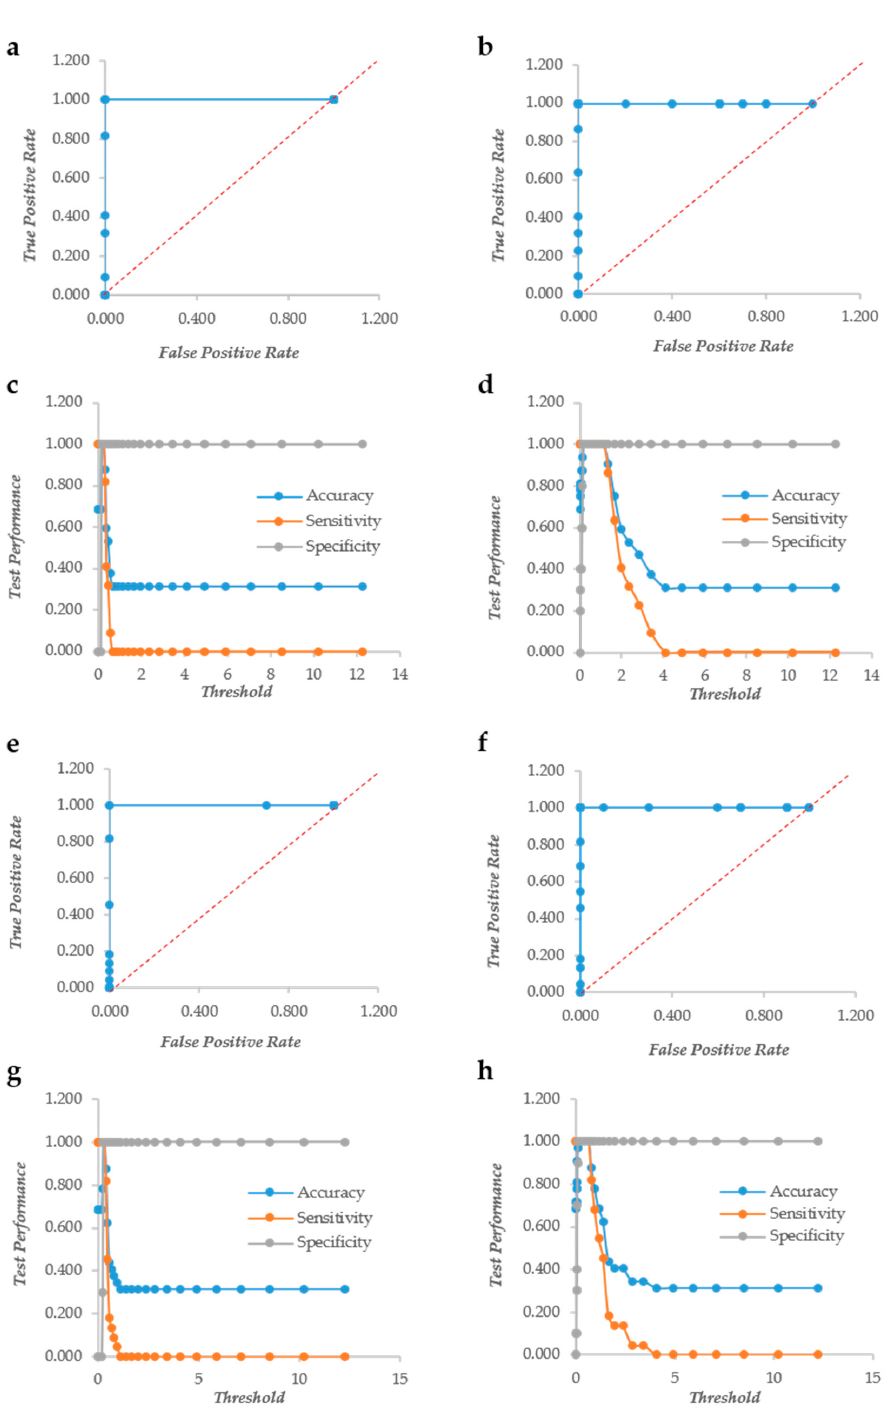
Figure 1. The Response Operator Characteristic (ROC) curves showing the ability to classify raw and normalized CV and XTT TECAN reads of Candida biofilm. The ROC curve and its parameters were obtained from raw read values recorded for CV staining (Panel ( a ) and ( c ) respectively), from normalized read values calculated for CV staining (Panel ( b ) and ( d ) respectively), from raw read values recorded for XTT staining (Panel ( e ) and ( g ) respectively) and from normalized read values calculated for XTT staining (Panel ( f ) and ( h ) respectively).